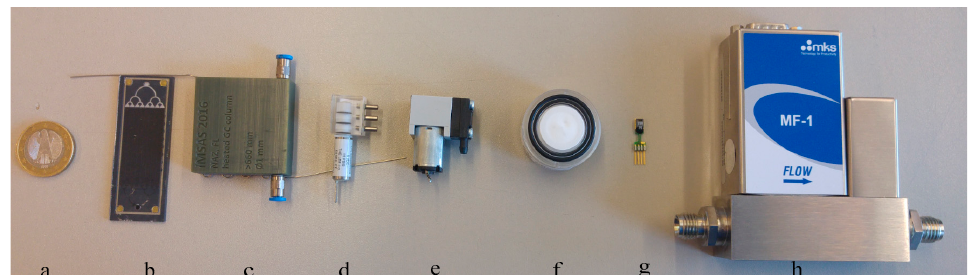
Figure 8. Individual components in the gas chromatographic system. ( a ) One euro (for size reference); ( b ) preconcentrator; ( c ) gas chromatographic column; ( d ) valve; ( e ) mini-pump; ( f ) electrochemical gas sensor; ( g ) humidity sensor; ( h ) mass flow controller.